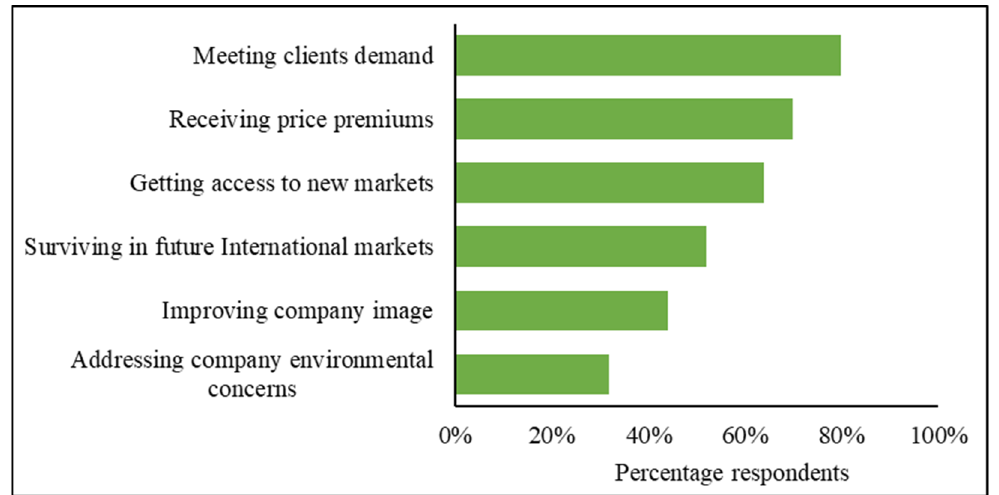
Figure 3. Reasons for respondent firms to become FSC certified (n = 50) (multiple responses possi ‐ ble).